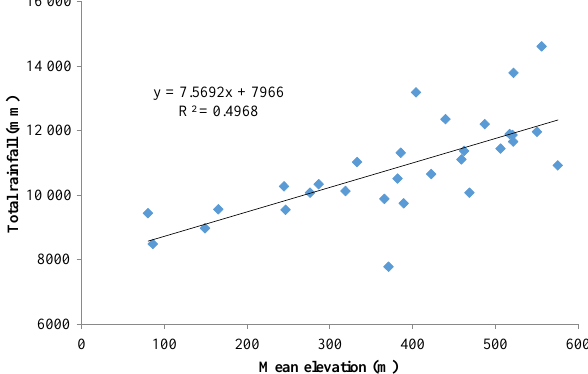
y = 7.5692x + 7966 R² = 0.4968